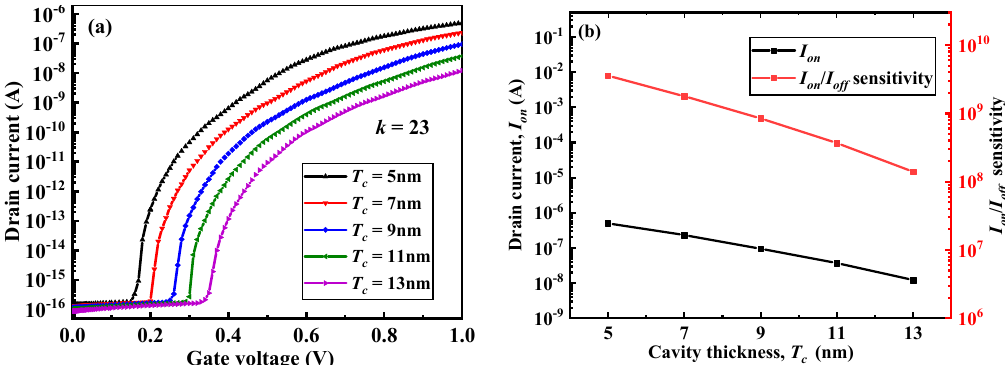
Figure 4. ( a ) Transfer characteristics and ( b ) I on and I on / I off sensitivity of the DM-LTFET biosensor for different values of the cavity thickness ( T c ) at V d = 0.5 V, V g = 1 V, and k = 23.